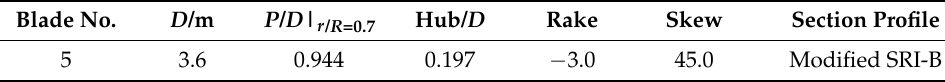
Table 4. Geometric parameters of the high-skew propeller.